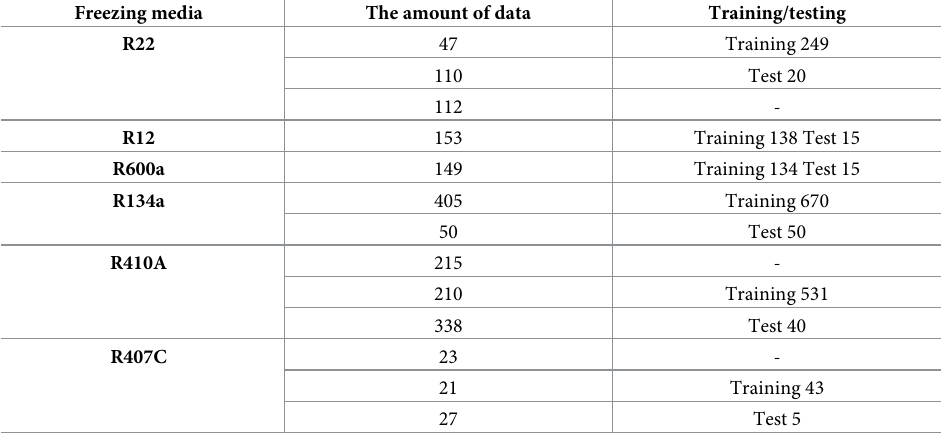
Table 1. Data sources and those for neural network